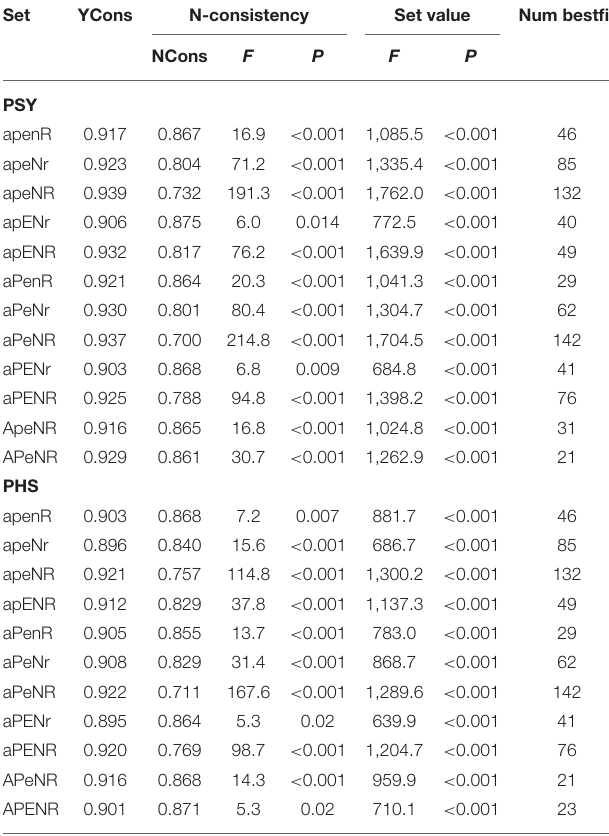
TABLE 3 | Consistency test for common sets of PSY and